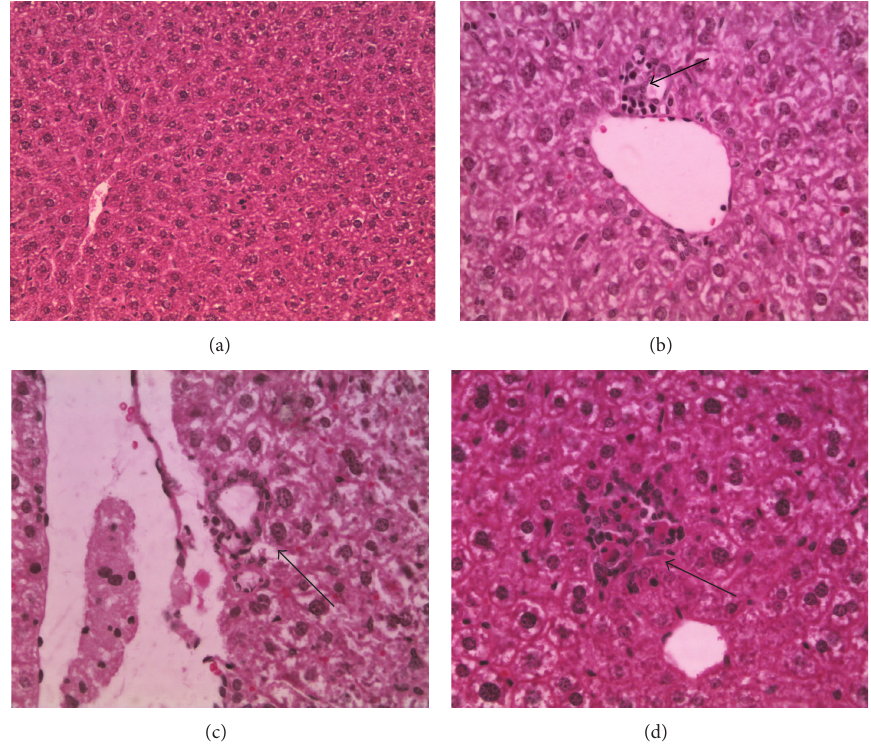
Figure 3: Hepatic sections. (a) Control, magnification 20x; (b) low concentration, magnification 40x; (c) media concentration, magnification 40x; (d) high concentration, magnification 40x; arrows are used to indicate inflammation focus.